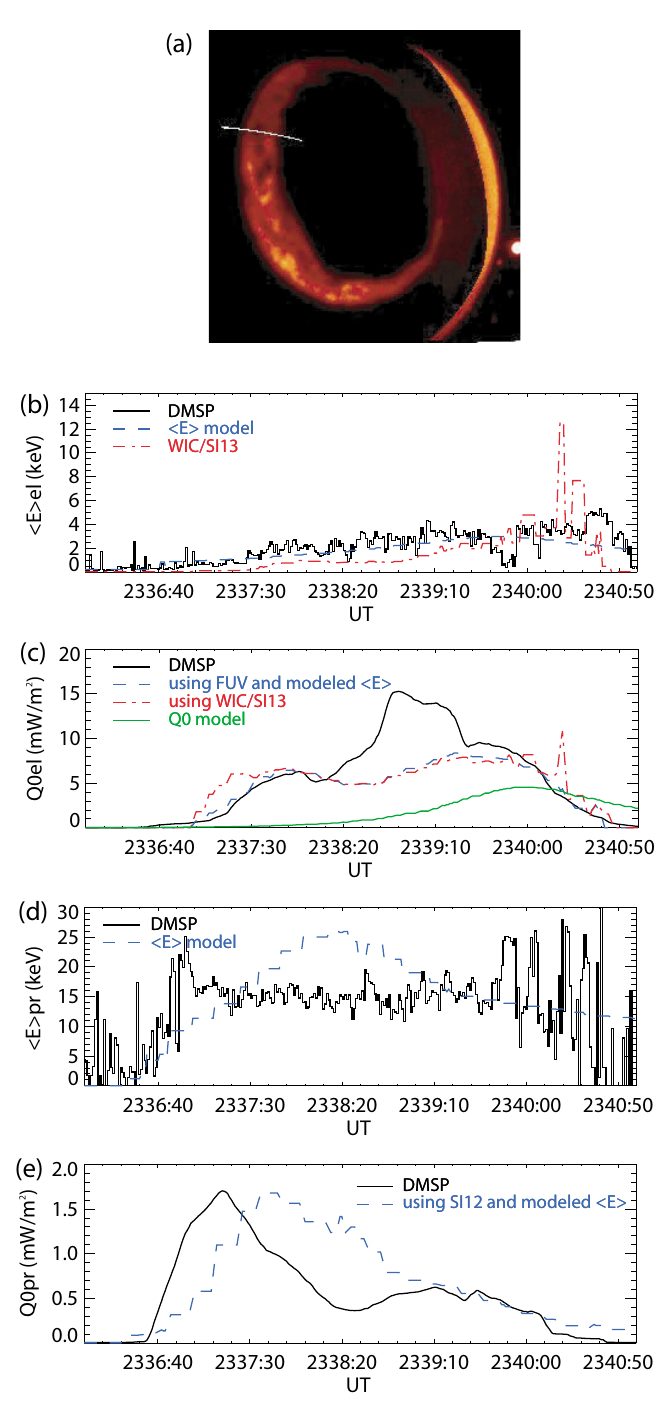
Fig. 4. Comparison between the particle precipitation characteristics evaluated from the FUV data and measured by the DMSP F15 satellite for 21 October 2001. (a) The mapped position of the DMSP F15 satellite is drawn on the WIC image. (b) The electron mean energy from Hardy et al. (1985) (blue curve) is compared with mean energy in situ measurement (black curve) and with mean energy evaluated from the ratio between WIC and SI13 images (red curve). (c) The electron energy flux evaluated using FUV and Hardy et al. (1985) mean energy (blue curve) and the one evaluated using the mean energy from WIC/SI13 ratio (red curve) are compared with DMSP energy flux measurement (black curve) and with Hardy et al. (1985) electron energy flux (green curve). (d) The proton mean energy from Hardy et al. (1991) (blue curve) is compared with the DMSP proton mean energy (black curve). (e) The energy flux evaluated from FUV-SI12 and the Hardy et al. (1991) mean energy (blue curve) is compared with in situ measurement (black